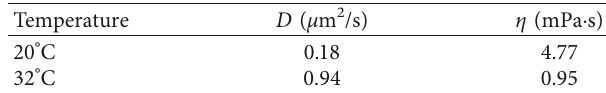
Figure 9: The displacement distribution of the SiO probes in PNIPAM dispersion at 20 ° C (red) and 32 ° C (black). Table 1: The diffusive coefficients of the probes and the viscosity of the